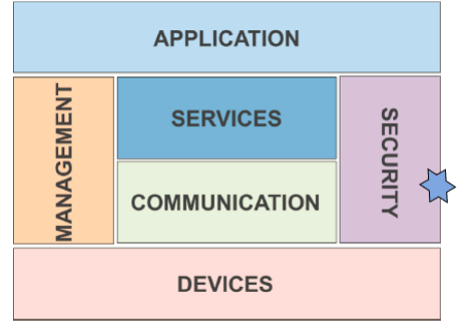
Figure 3. Recommended IoT architecture of smart agro